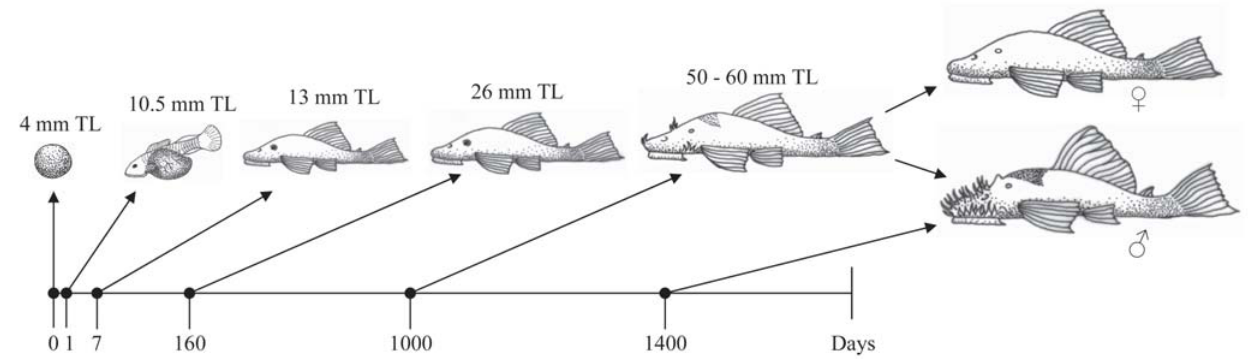
Fig. 7. Summary of the life cycle of Ancistrus cryptophthalmus from Passa Três